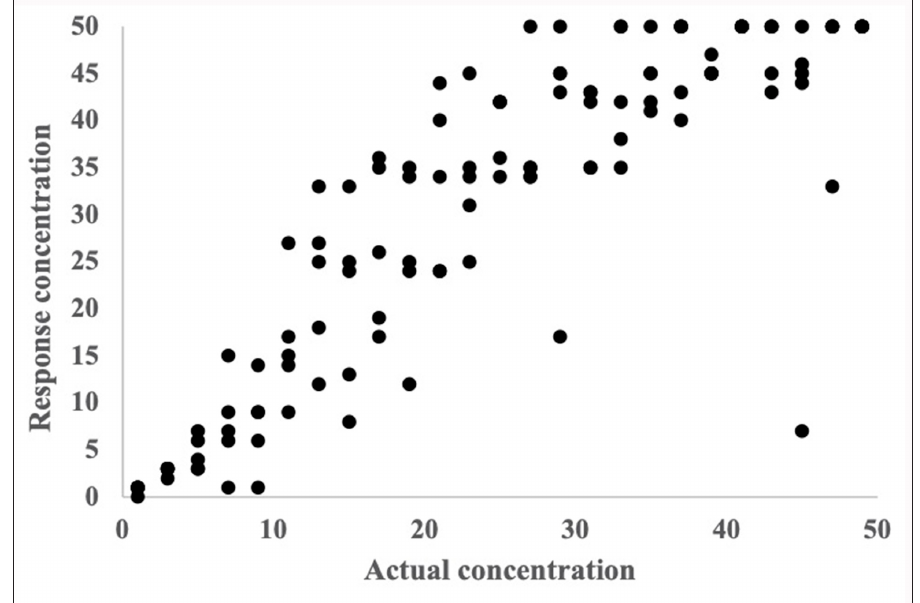
Figure 2 A scatter plot of data produced by continuous app users that compares the actual concentration of nitrate to the volunteers’ recorded values.